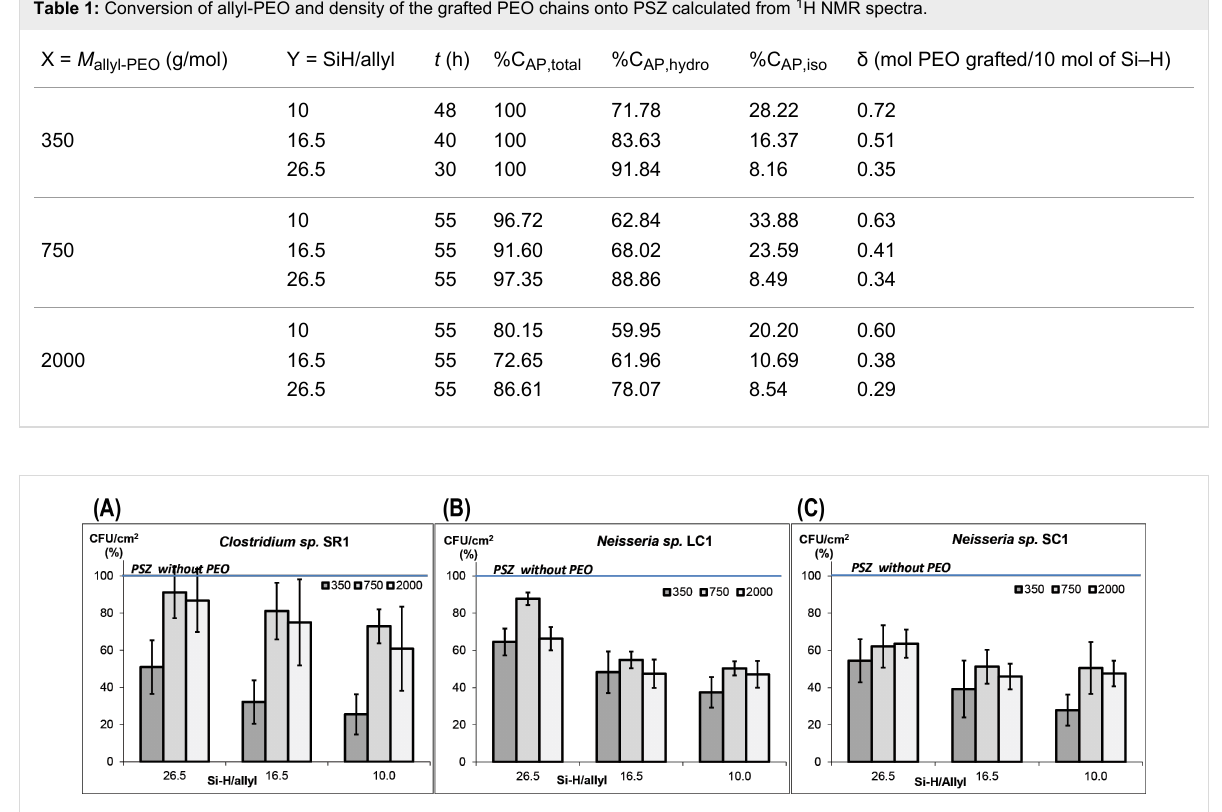
Figure 6: Marine bacteria adhesion on PSZ-PEO surfaces (mean ± SD, 100% corresponds to 13 × 10 2 CFU/cm 2 for Clostridium sp. SR1 (A); 8 × 10 3 CFU/cm 2 for Neisseria sp. LC1 (B) and 11 × 10 3 CFU/cm 2 for Neisseria sp. SC1